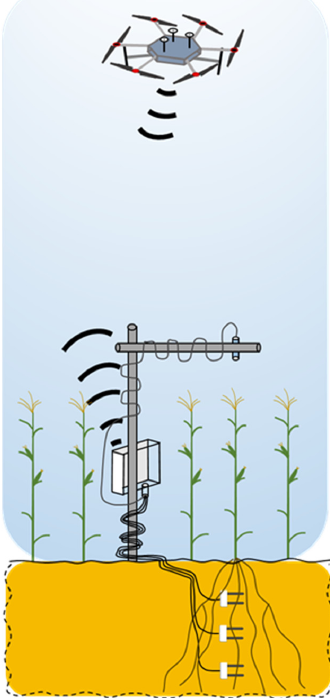
Figure 1. Close-up view of the stationary sensor node station comprising of infrared radiometer and soil